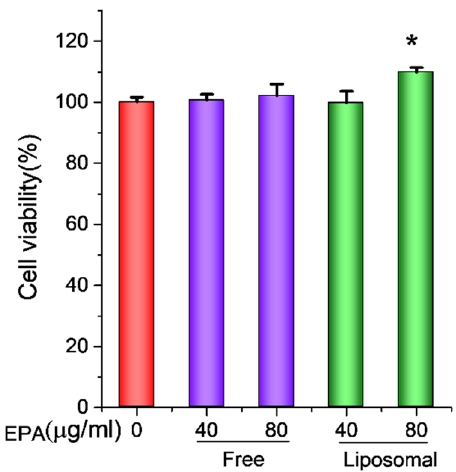
Figure 4. The cell viability enhancement by EPA-liposomes. The differentiated HL60 cells were treated with either free EPA or EPA-liposomes at the indicated concentrations in the presence of LPS (100 ng/mL) for 24 h and the cell viability was determined by the CCK-8 kit. The data are expressed as means ± SD. * p < 0.05, n = 6.